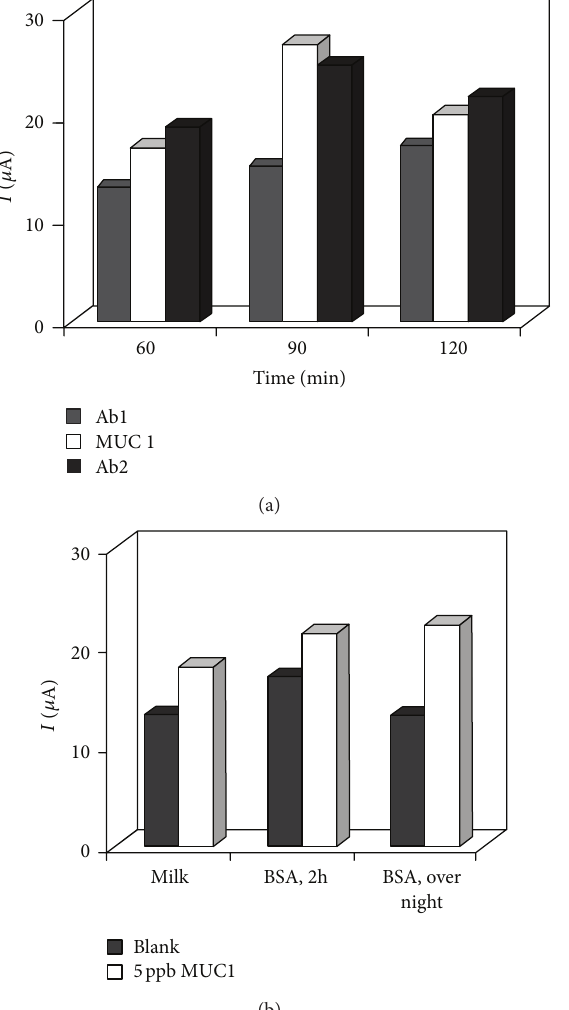
Figure 2: Optimization diagram for Ab1, MUC1 antigen, and Ab2 incubation times (a) and for blocking agent type and incubation time (b).